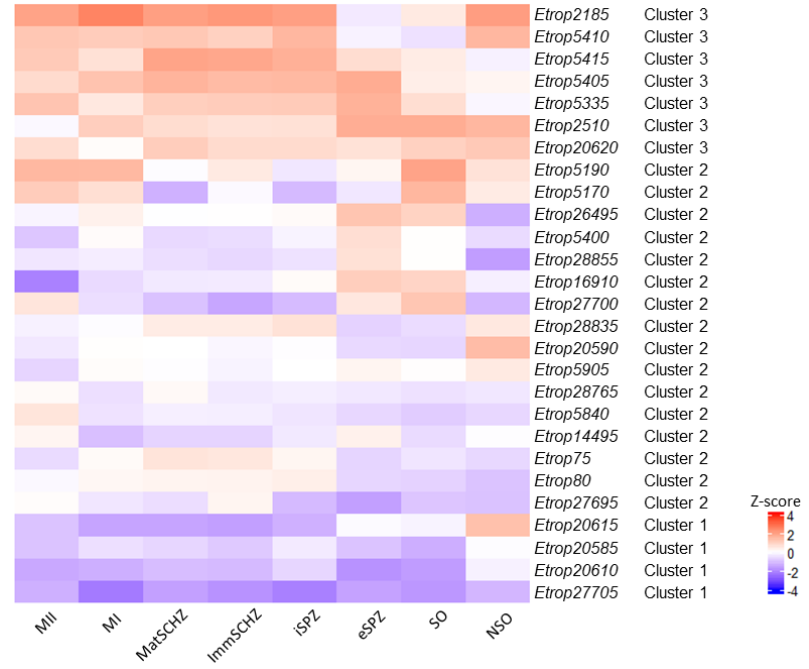
Figure 7. Heatmap of differentially transcribed rhoptry kinase genes in the Et WIS strain. Red color indicates a rhoptry kinase transcription level higher than the mean and blue colour represents a transcription level lower than the mean. NSO non-sporulated oocysts, SO sporulated oocysts, eSPZ extracellular sporozoites, iSPZ intracellular sporozoites, ImmSCHZ immature schizonts, MatSCHZ mature schizonts, MI first-generation merozoites, and MII second-generation merozoites. The cluster resulting from the hierarchical clustering analysis are indicated.